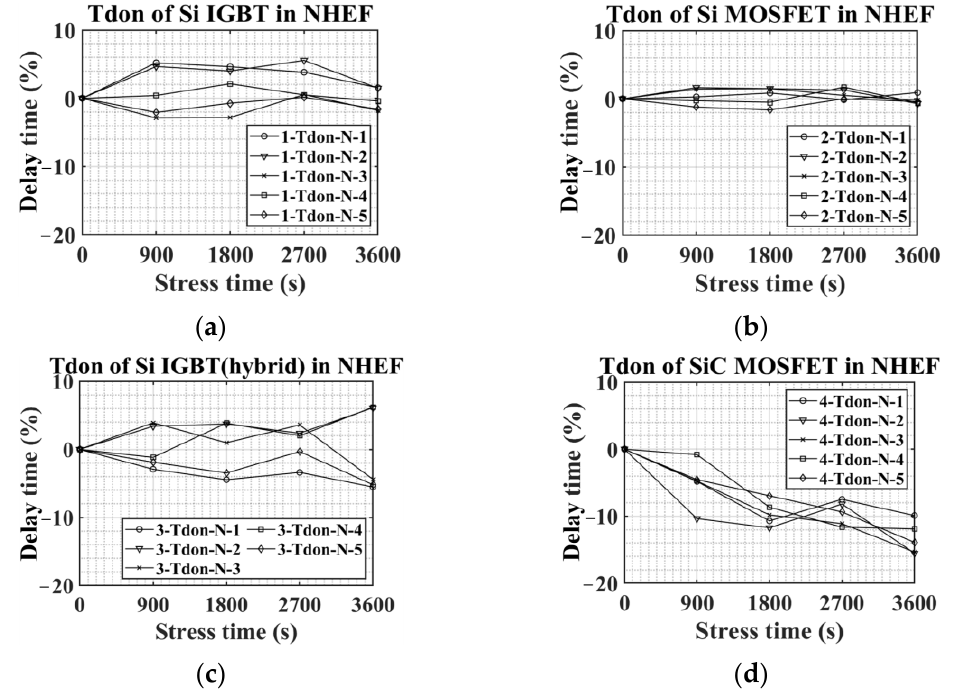
Figure 15. T don variations in NHEF stress: ( a ) Si IGBT, ( b ) Si MOSFET, ( c ) Si IGBT with SiC diode, and ( d ) SiC MOSFET.